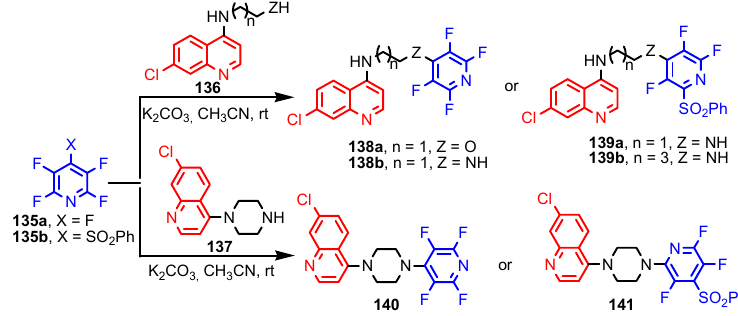
135a , X = F 135b , X = SO 2 Ph